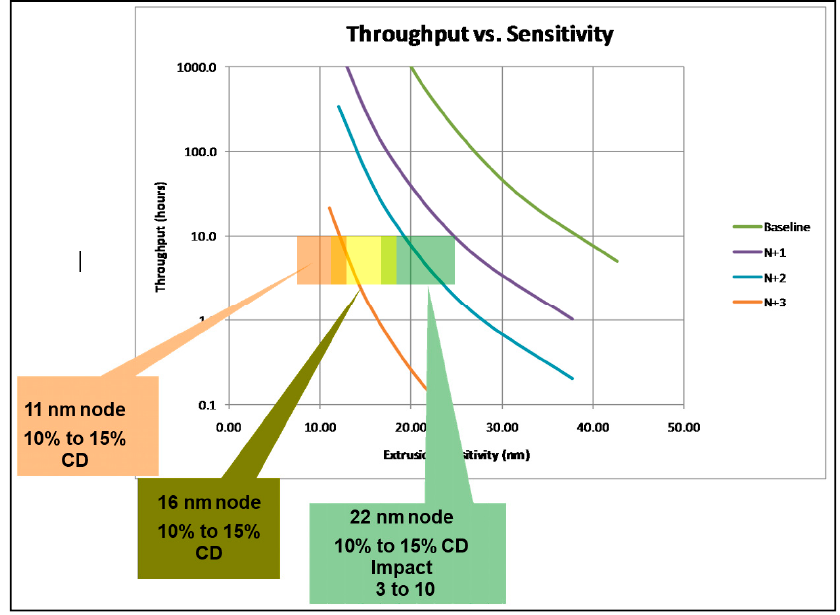
Figure 26. Throughput versus sensitivity distribution of various design node.